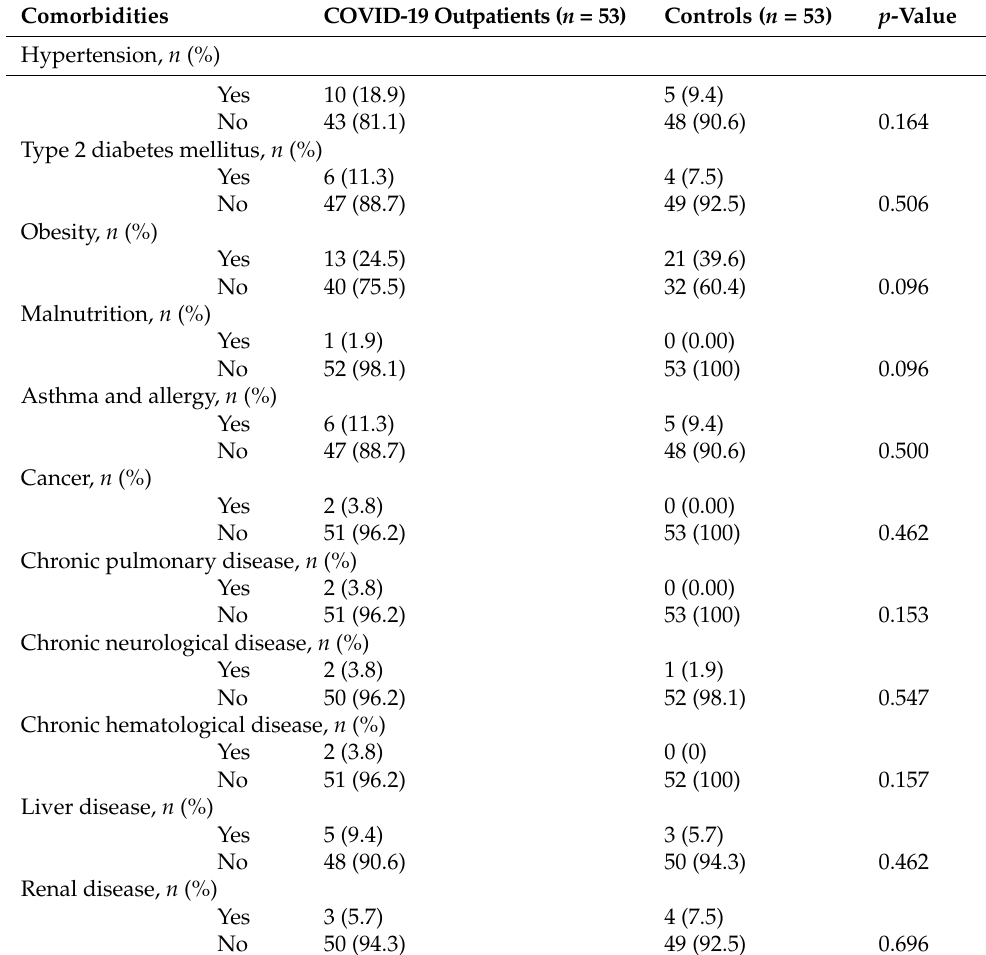
Table 2. Comorbidities of patients infected with COVID-19 and matched controls at baseline † .